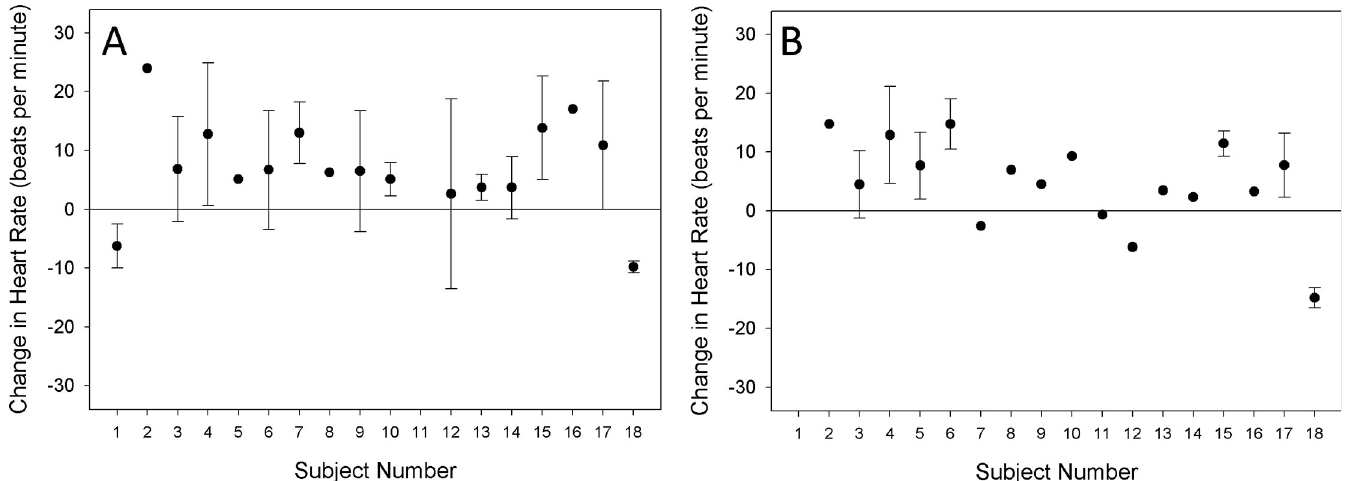
Fig 3. Mean differences in observed HR (SD) across individual’s events (some only had one event) as compared to baseline during non-exam EMA-reported stressors (panel A) and exams reported by participants during screening (panel B).